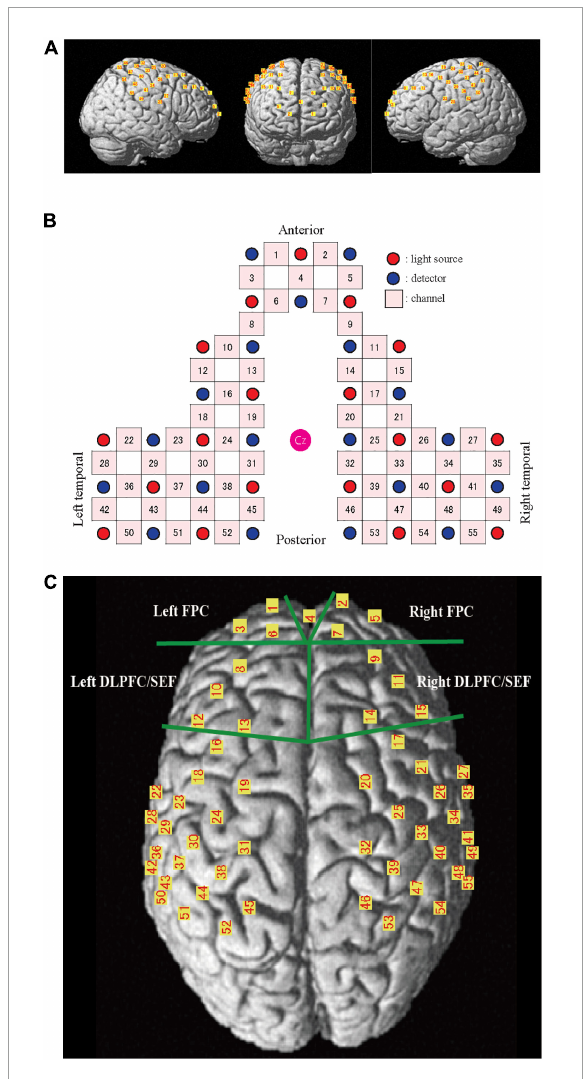
FIGURE2 Channel location on the cortical surface. (A) Predicted location of each channel on the cortical surface. The front, right, and left hemisphere of a single-rendered brain illustrate the average locations of the 55 channels identified by number. (B) Schematic illustration of the location of each optode and channel where Cz represents the vertex. (C) Near-infrared spectroscopy (NIRS) channels and regions of interest (ROI). FPC, frontal pole; DLPFC/SEF, dorsolateral prefrontal cortex and includes frontal eye